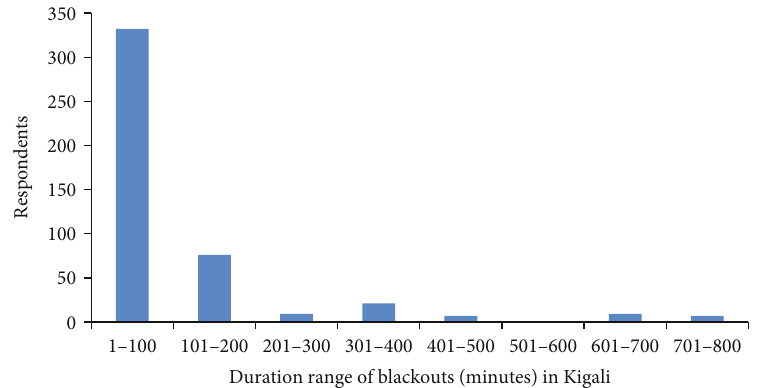
Figure 21: Power outage in Kigali City (authors ’ calculation based on living household conditions, EICV 5, 2017).